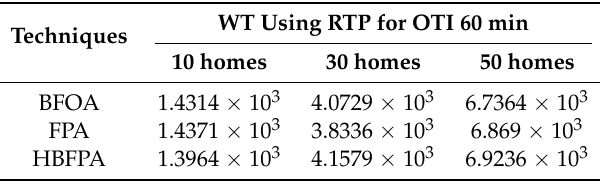
Table 22. Waiting time for 24 h (for multiple homes).